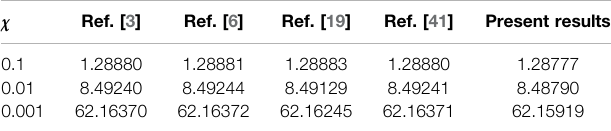
TABLE 1 | Comparative investigation for f ″ ( χ ) when. M (cid:2) We (cid:2) 0